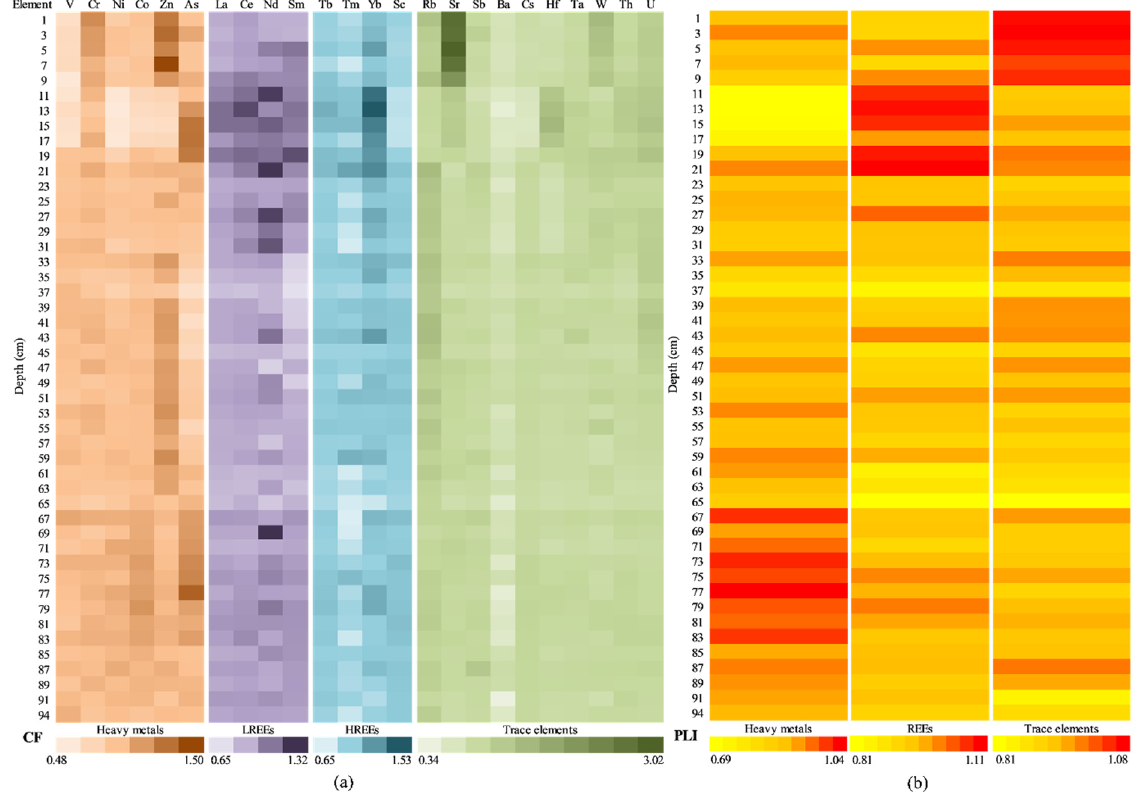
Figure 14. Contamination factors (CFs) ( a ) and pollution load indices (PLIs) ( b ) calculated from the Amara Lake sediment core (94 cm depth).